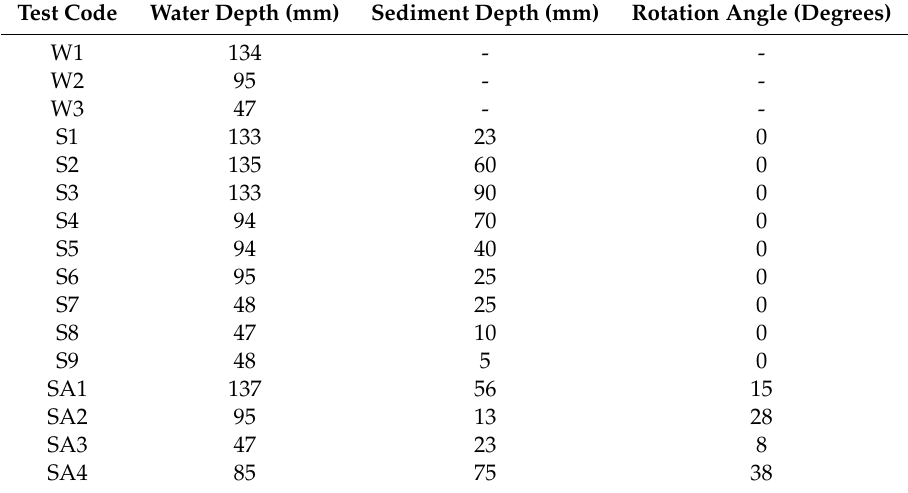
Table 1. Summary of tests conducted related to the depths of water and sediment, and the rotation angle. Test Code Water Depth